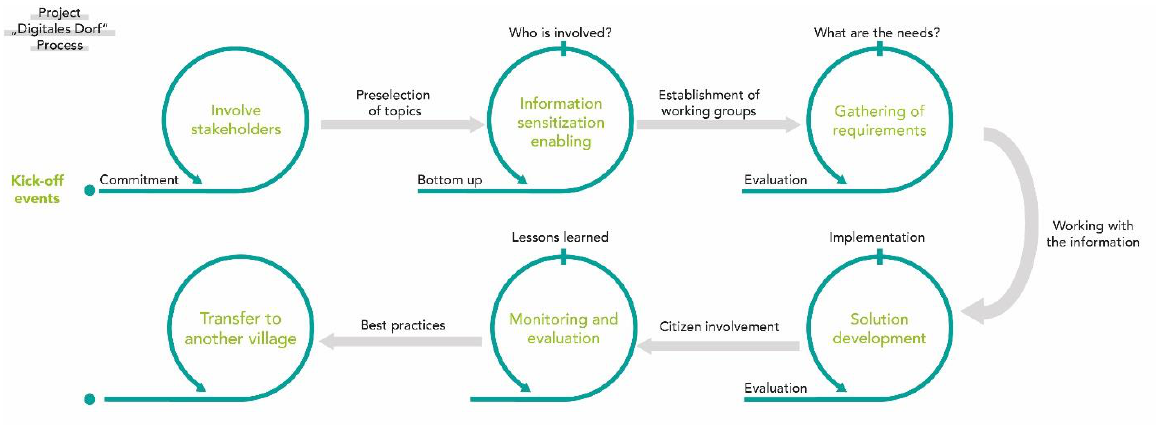
Figure 4: Digitalization process in the living lab "Digitales Dorf Bayern"